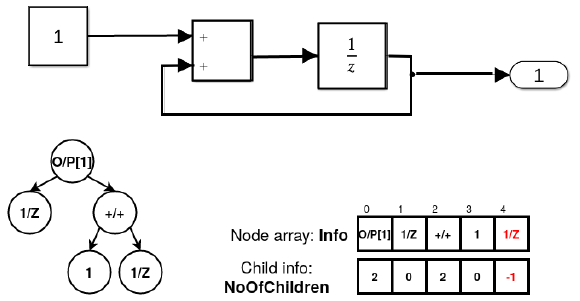
Figure 9. Simulink